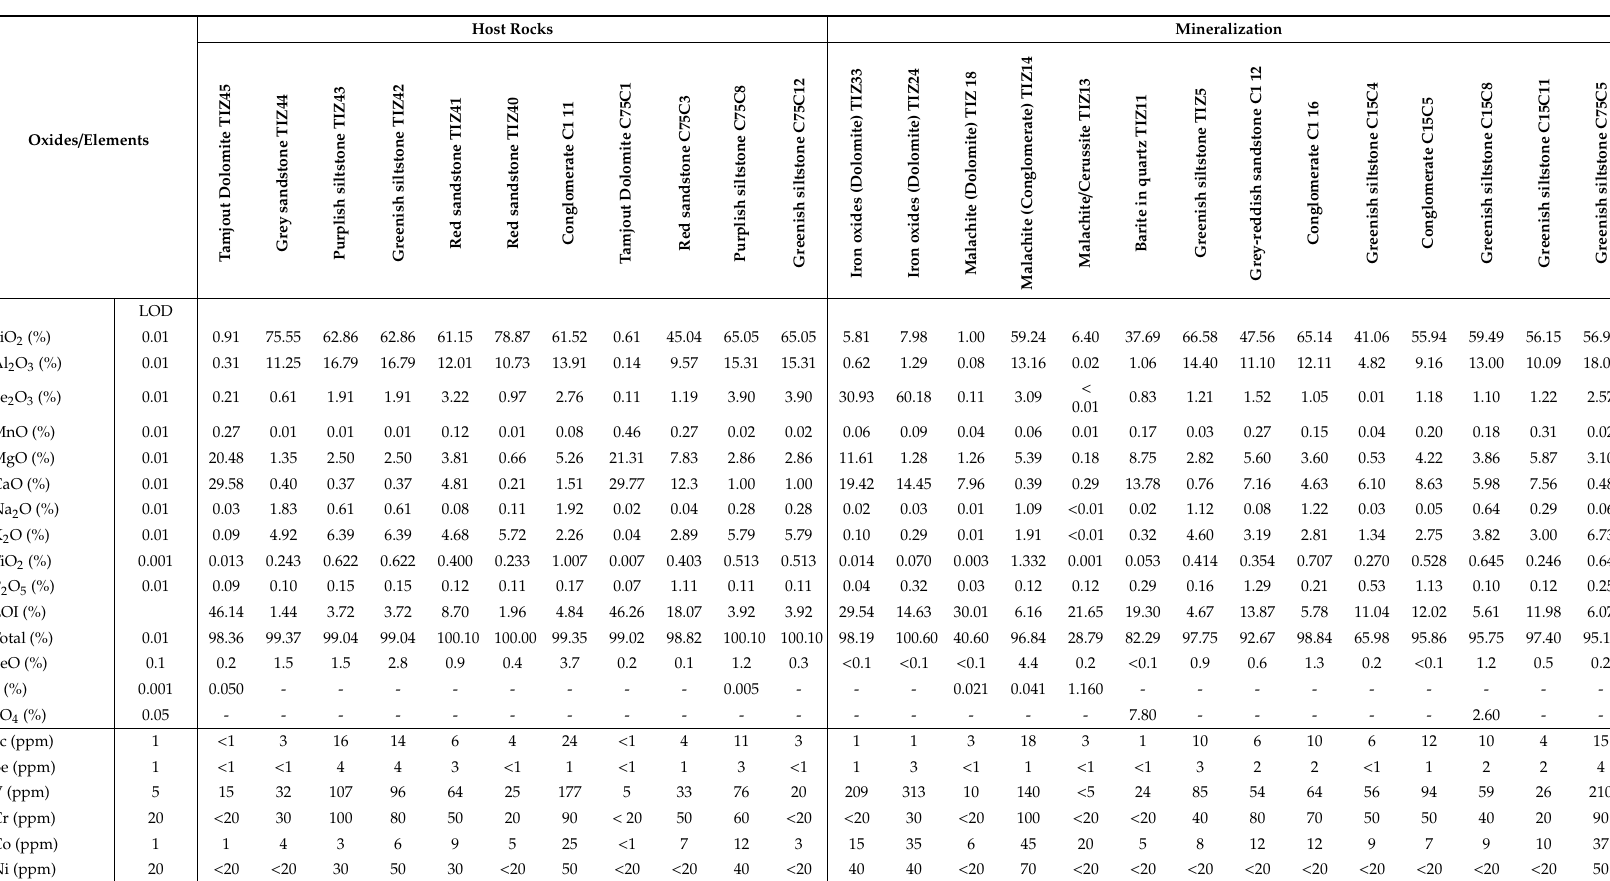
Table 1. Results of geochemical analyses for selected samples of host rocks and mineralization / weathered rocks. Major elements are listed in %, while minor elements and REE are listed in ppm, except for values with an asterisk (*) which are in %. LOD—Limit of